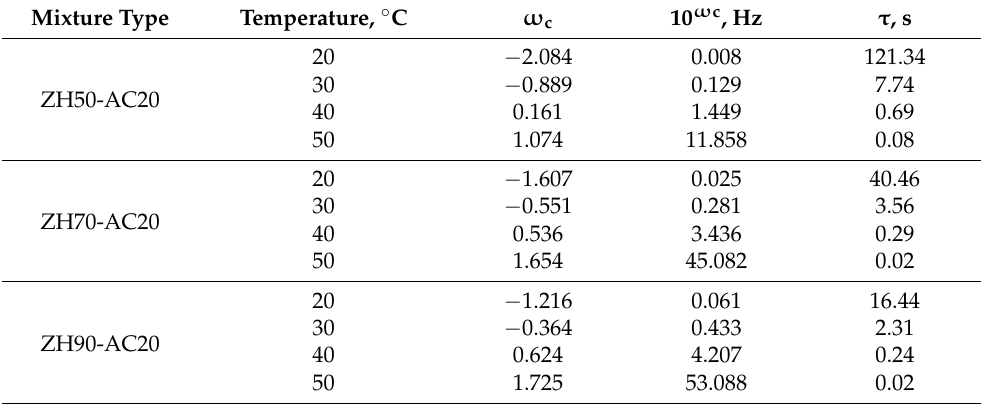
Table 3. Peak position of phase angle and relaxation